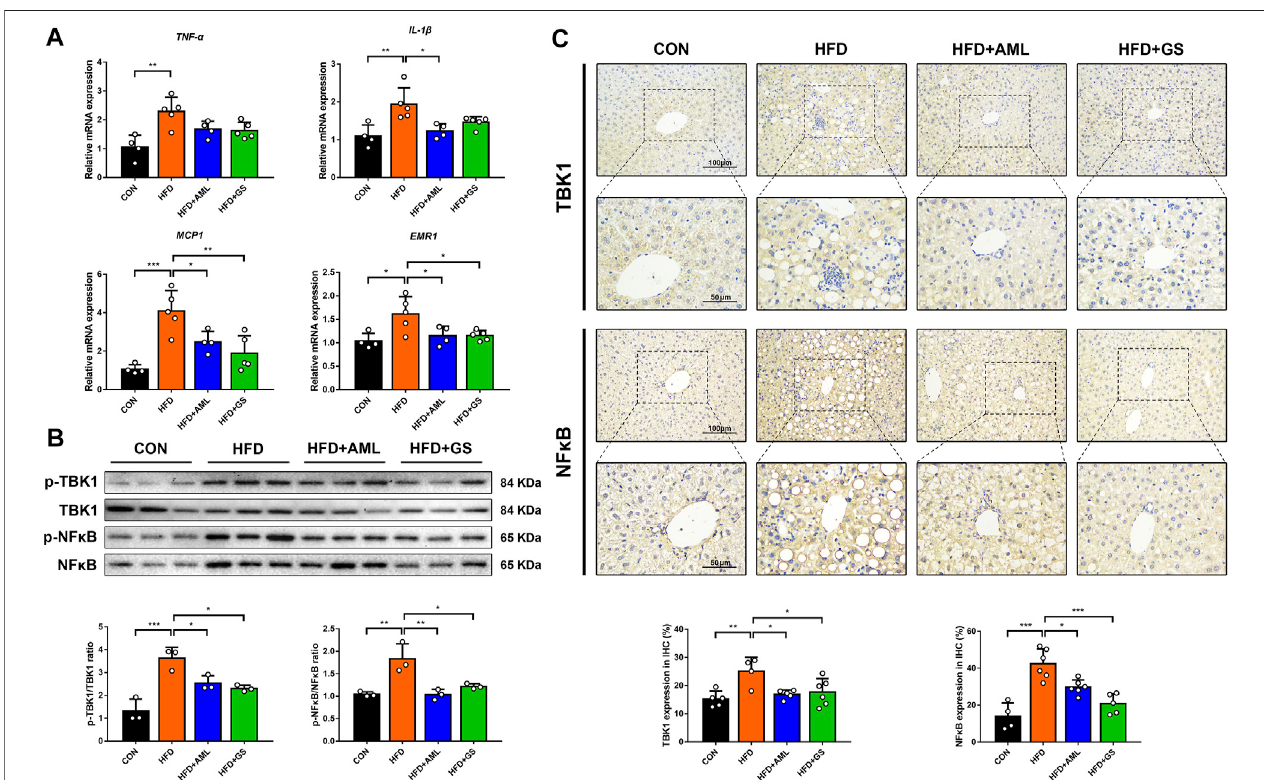
FIGURE3| GSregulatedTBK1torestrainin fl ammatorycascade. (A) TherelativemRNAexpressionsinlivertissuesweredeterminedbyPCR, n (cid:1) 4 – 5. (B) Western blot analyses of p-TBK1, TBK1, p-NF- κ B and NF- κ B in liver tissues and statistical graphs, n (cid:1) 3. (C) Immunohistochemical staining of TBK1 and NF- κ B and statistical graphs, n (cid:1) 4 – 6. Results are presented as means ± SD. *p < 0.05, **p < 0.01, ***p < 0.001